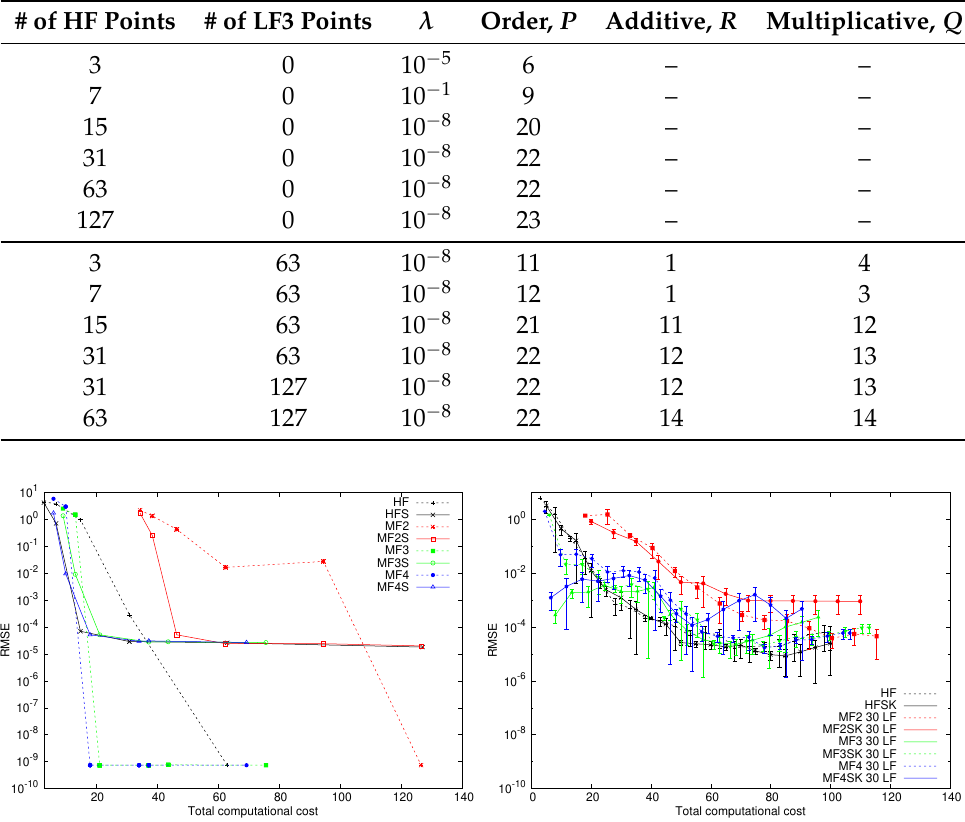
Figure 10. Forrester function RMSE (from left to right, PCE and